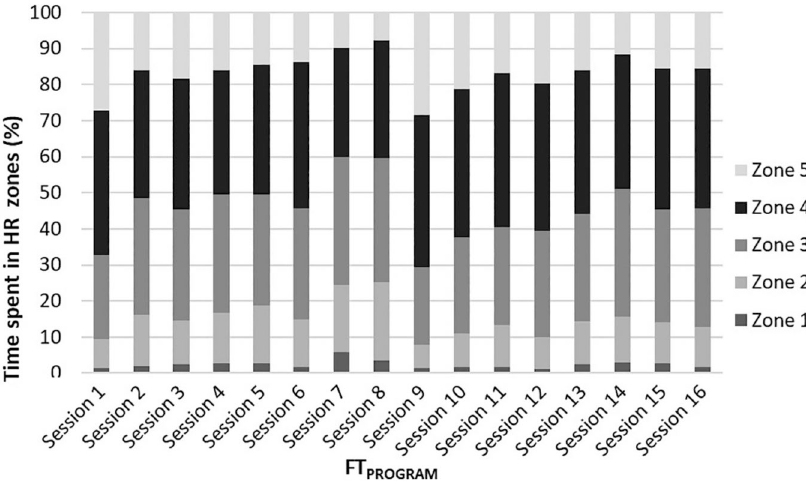
Figure 3 - HR distribution in intensity effort zones (zone 1: 50-60% HR max ; zone 2: > 60-70% HR max , zone 3: > 70-80% HR max ; zone 4: > 80-90% HR max ; zone 5: > 90% HR max ) during all sessions of the FT PROGRAM (n = 9). (F = 8.488).